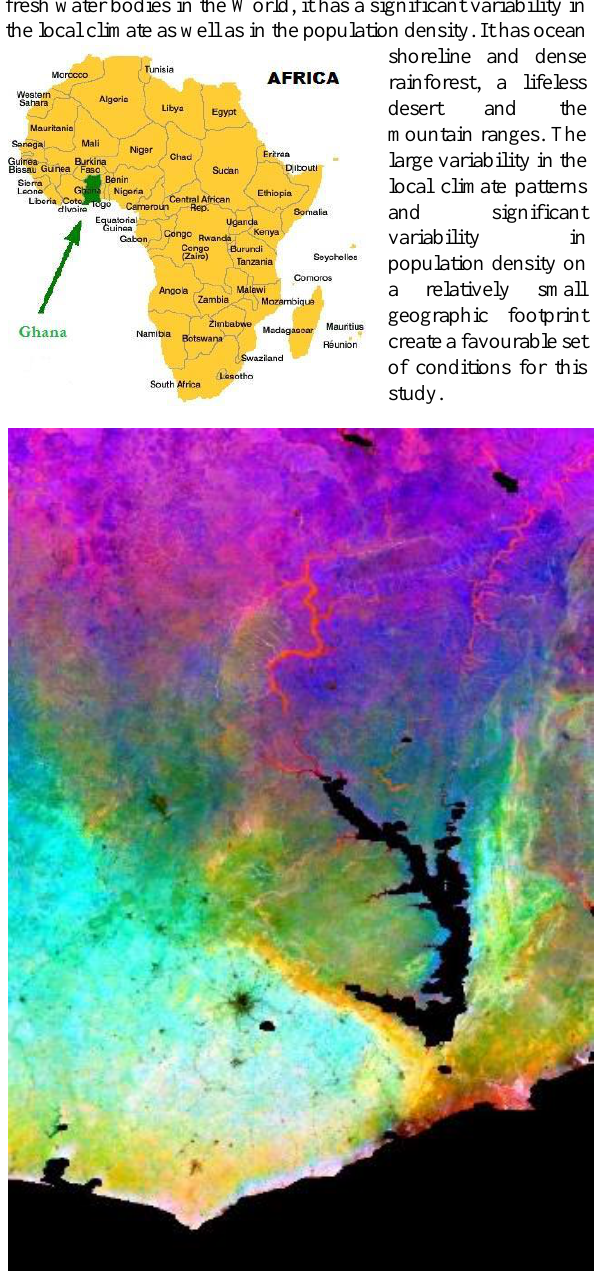
Figure 1. Pseudo-color image of the first three principal components Figure 1.Pseudo-color image of the first three principal